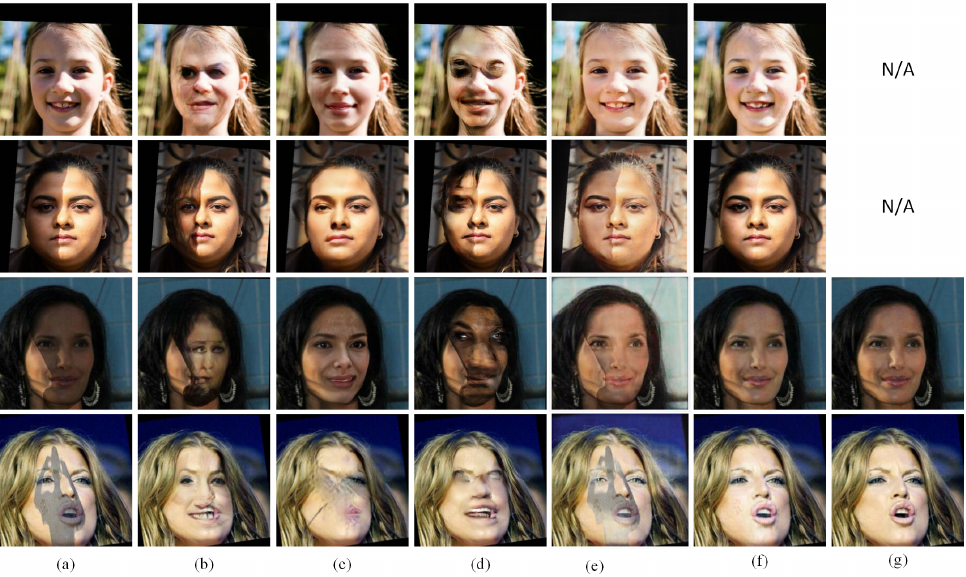
Figure 2. Visual comparison of shadow removal. ( a ) Input image, ( b ) EdgeConnect [10], ( c ) Par- tial Convolution, [14], ( d ) Gated Convolution [15], ( e ) Ghost-free Shadow removal [6], ( f ) Ours, ( g ) Ground truth. Note: There is no ground truth for the first couple of rows since these samples are real world shadow images collected from the Internet. The last two samples are from our synthetic